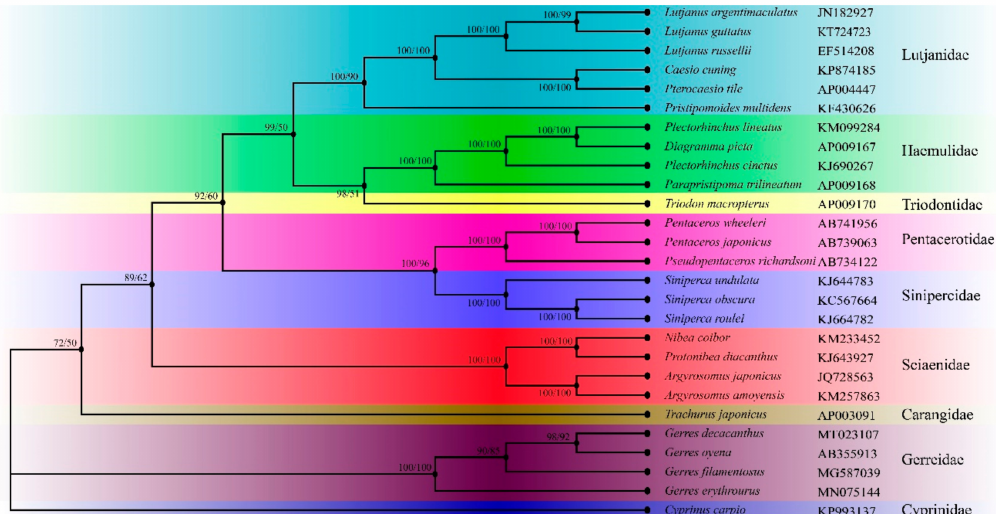
Figure 8. Phylogenetic tree of 27 Perciformes species constructed by Bayesian Inference (BI) and maximum Likelihood (ML) methods base on concatenated sequences of 13 PCGs. Cyprinus carpio was used as the outgroup. Numerals at nodes are Bayesian posterior probabilities (left) and bootstrap support values (right), respectively.